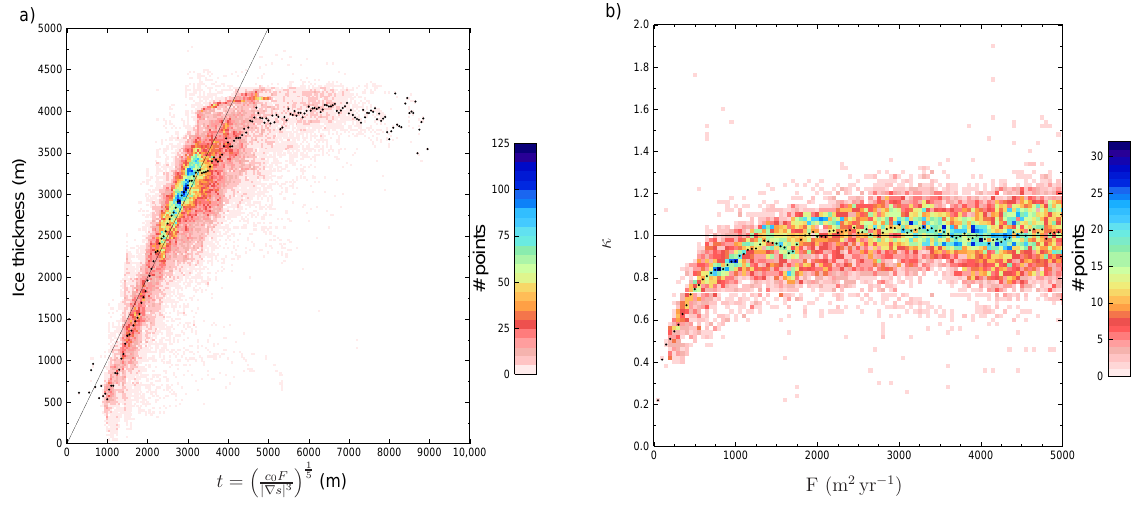
Fig. 3. (a) Basin wide characteristics from the ICECAP data and the ice dynamics based interpolation. Binned distribution of measured ice thickness and pseudo thickness ( t ). Also shown are medians of ice thickness ( D ) of the binned distribution (dots) and the line of slope 1 corresponding to c 0 = 10 5 m 3 yr. Note the breakaway from constant slope at high pseudo thickness. This corresponds to ridges, saddles, Lake Vostok and ice streams. (b) Binned distribution of κ at low ice fluxes. Also shown are medians of κ of the binned distribution (dots) and the constant line κ = 1 .